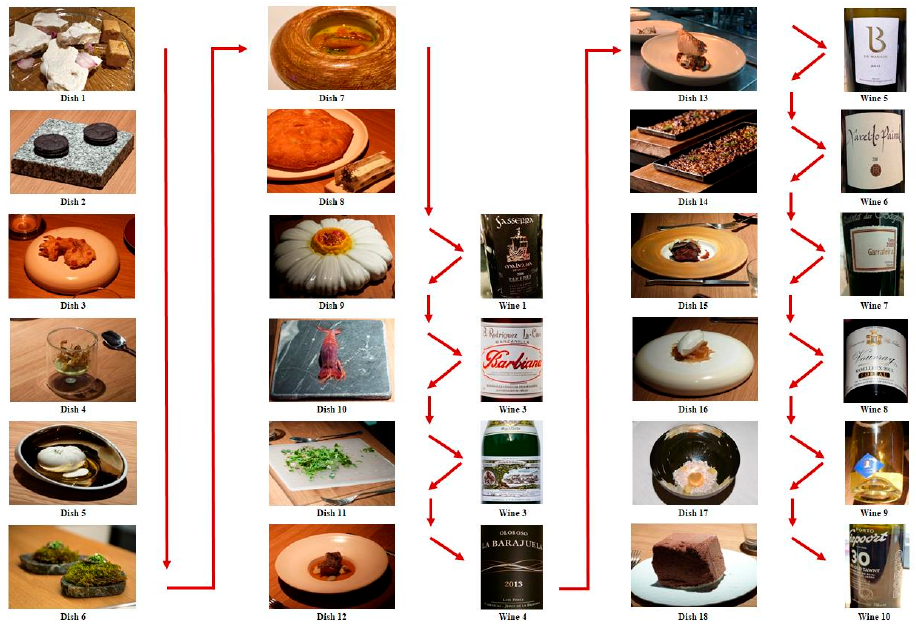
Figure 1. Stimulus (dishes and wines) and order established by the chef and sommelier. Source: Prepared by the